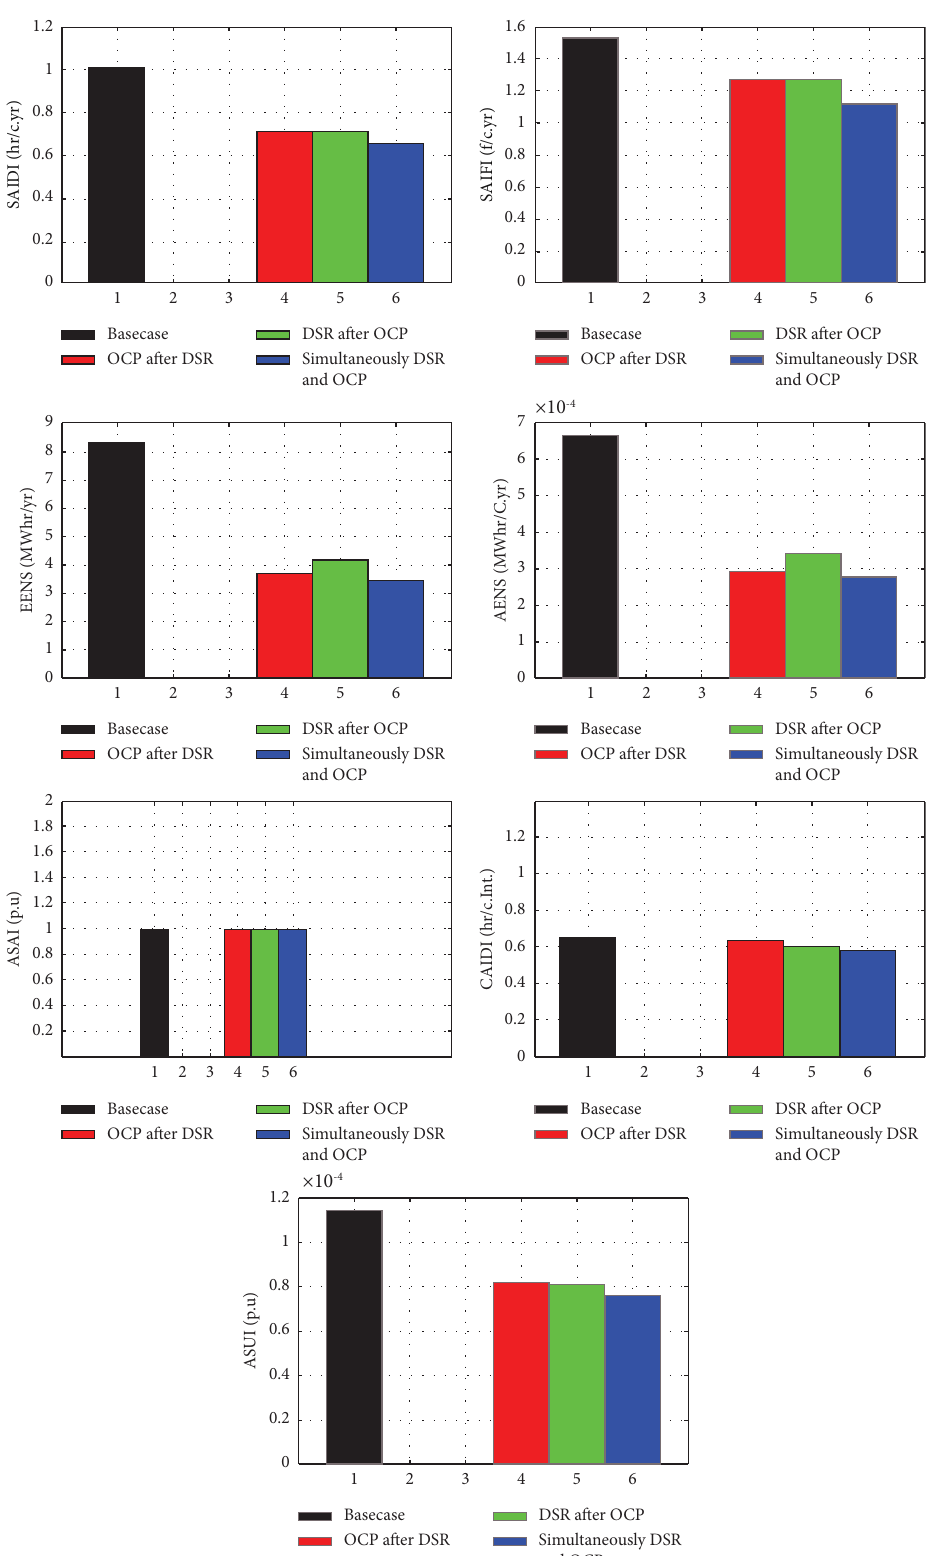
Figure 21: Reliability indices for 69-bus with using the BSSA algorithm for three scenarios with the base